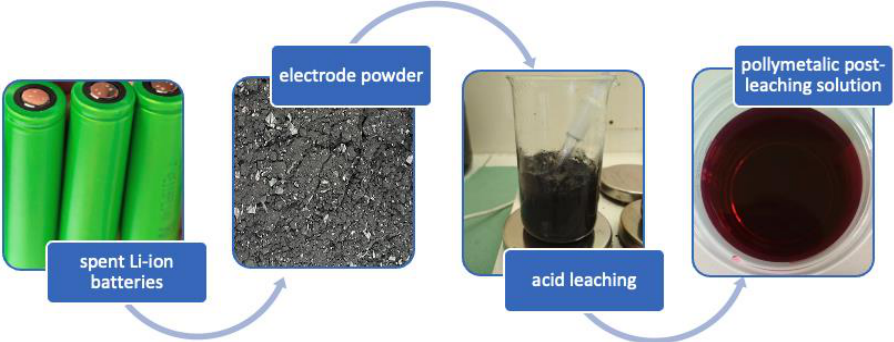
Figure 9. Schematic diagram of the solution prepared for use as a dopant.